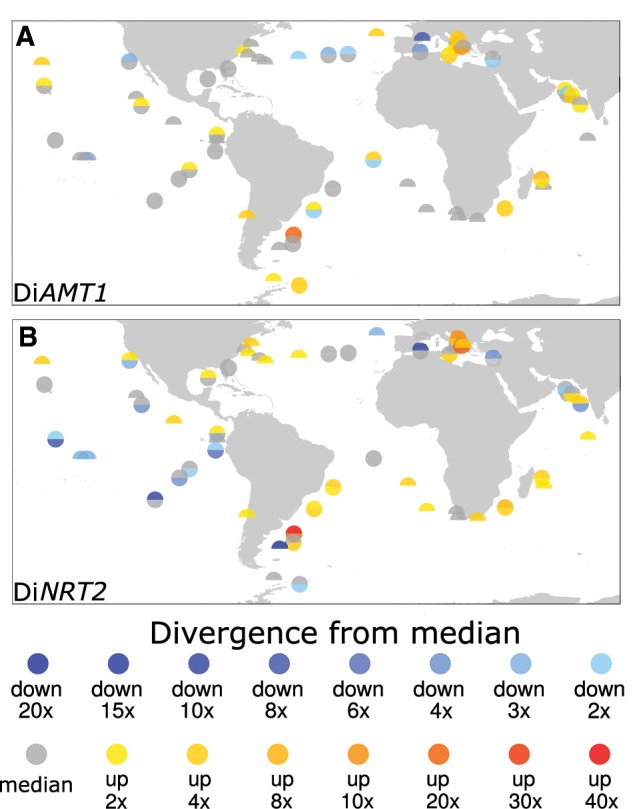
Deviance of mRNA levels of DiAMT1 (A) and DiNRT2 (B) in the size class 20–180 μm. The sum of transcripts assigned to each gene family present at every site is here expressed as fold-change over the median mRNA abundance of the same gene family over the whole Tara Oceans data set. Each circle corresponds to a sampling site, while the upper semicircle is filled with the surface value the lower semicircle is filled with the deep chlorophyll maximum information where it is available.